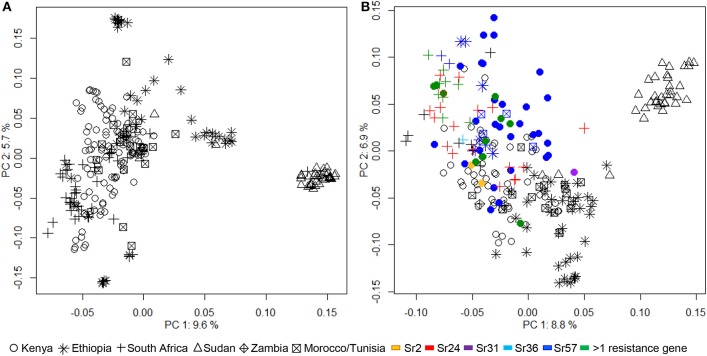
Analysis of population structure within the African wheat collection calculated by principal component analyses (PCA) performed with (A) DArT markers and (B) 123 simple sequence repeat or sequence tagged sites casual or linked to known Sr genes. Lines predicted by haplotype analysis to contain known Sr genes Sr2, Sr24, Sr31, Sr36, Sr57, or a combination of 2 or more Sr genes are indicated.